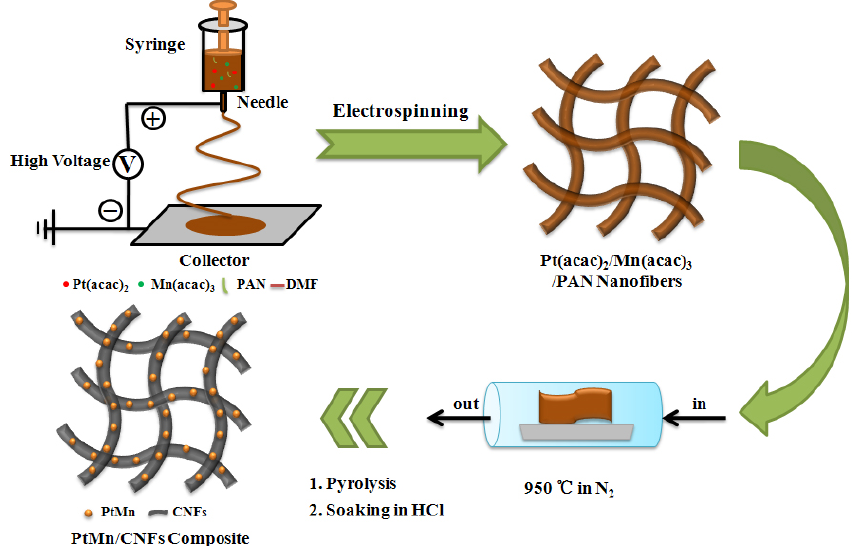
Figure 1. Schematic diagram for the preparation of PtMn/carbon nanofibers (CNFs).